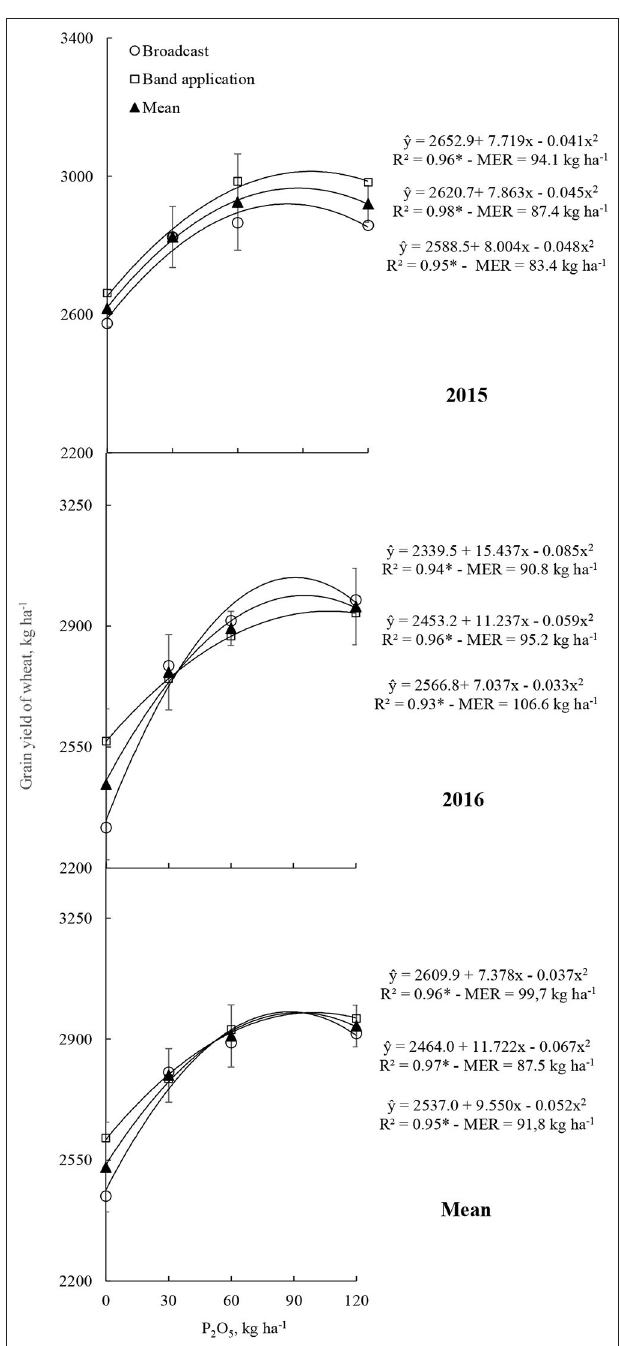
FIGURE 4 | Relationship of the residual effect of P 2 O 5 rates applied through broadcast or band application in soybean crop and wheat grain yield in two growing seasons. MER, maximum estimated rate. *Significant ( F -test, p ≤ 0.05). Londrina, Paraná State,